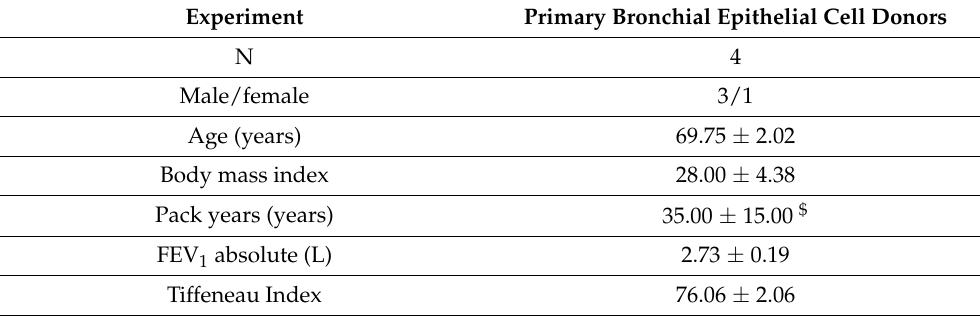
Table 1. Characteristics of primary human bronchial epithelial cell